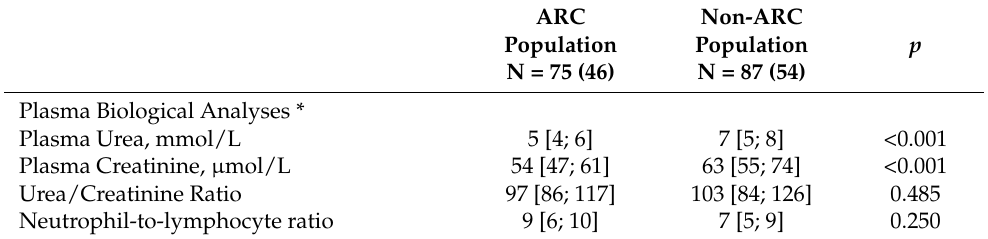
Table 4. Biological parameters and nitrogen balance compared in ARC vs. non-ARC